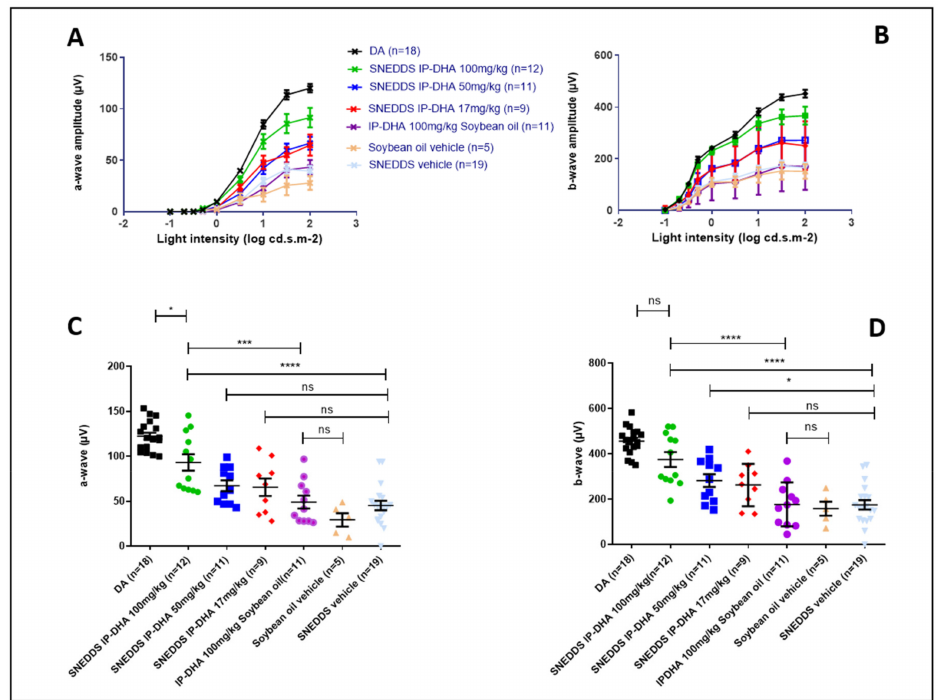
Figure 7. Light intensity of a- ( A ) and b- ( B ) wave and maximum light intensity of a- ( C ) and b- ( D ) wave of ABCA4KO mice after oral administration of various pretreatments and retinal degeneration induced through acute light stress. One-way ANOVA with Bonferroni’s multicomparison test: